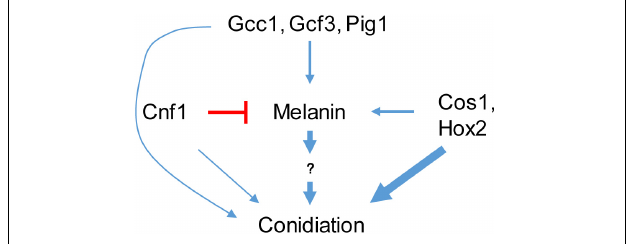
FIGURE 8 | A schematic diagram of melanin and transcription factors regulating